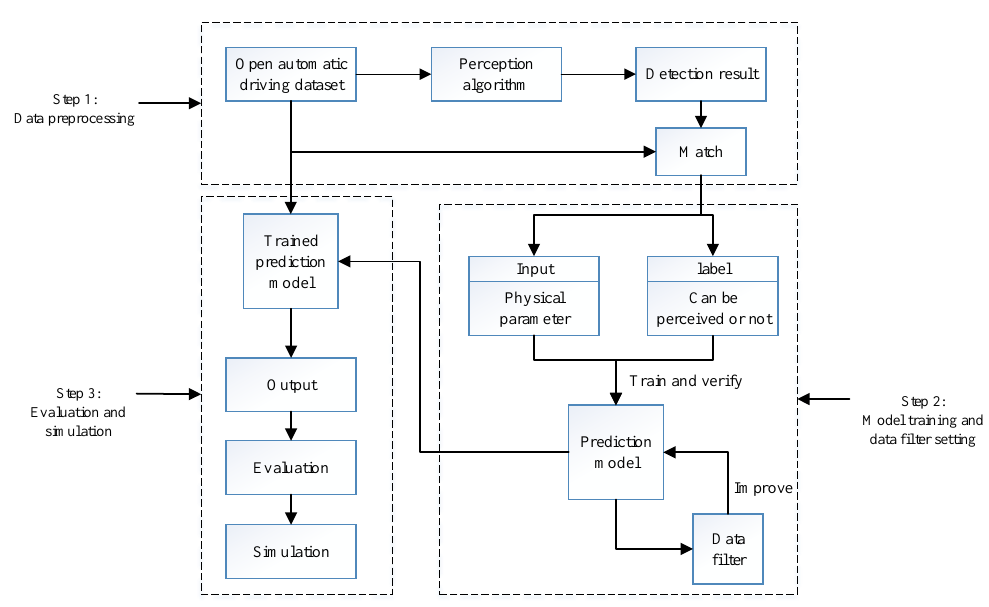
Figure 2. The system model. The model is built and evaluated in three steps.